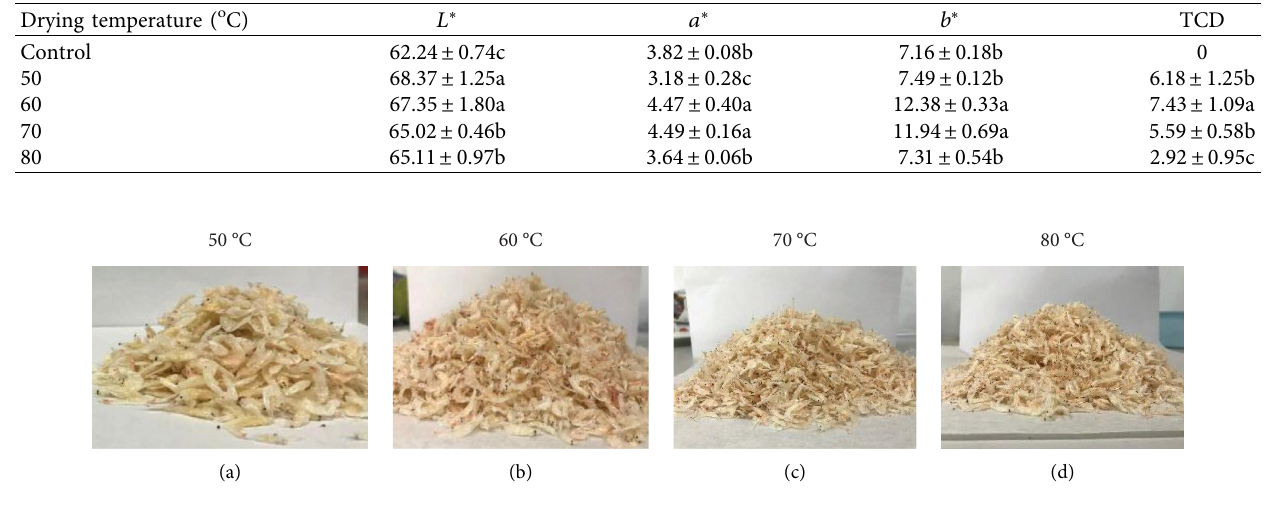
Figure 8: Dried small shrimp. (a) 50 ° C, (b) 60 ° C, (c) 70 ° C, and (d) 80 ° C.